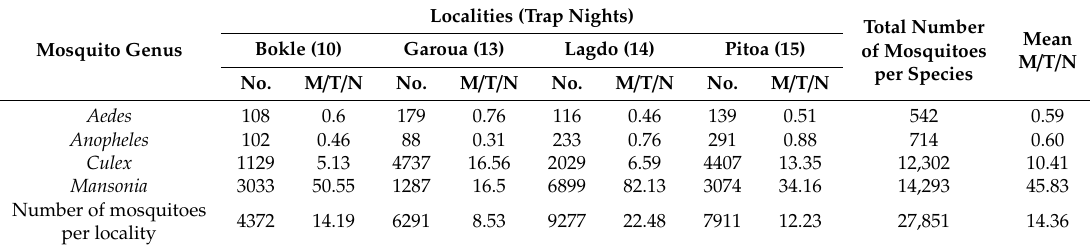
Table 1. Summary of mosquito genera captured: diversity, distribution, and abundance per locality.